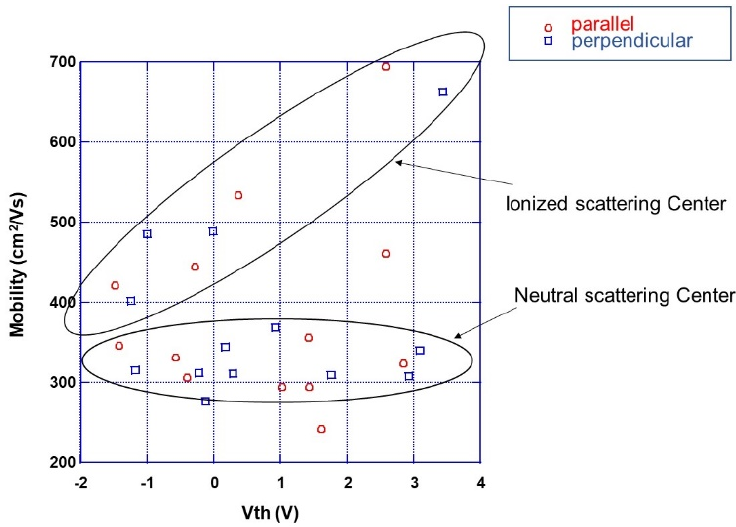
Figure 20. Correlation between measured effective mobility and threshold voltage for parallel TFTs (red circle) and perpendicular TFTs (blue square).